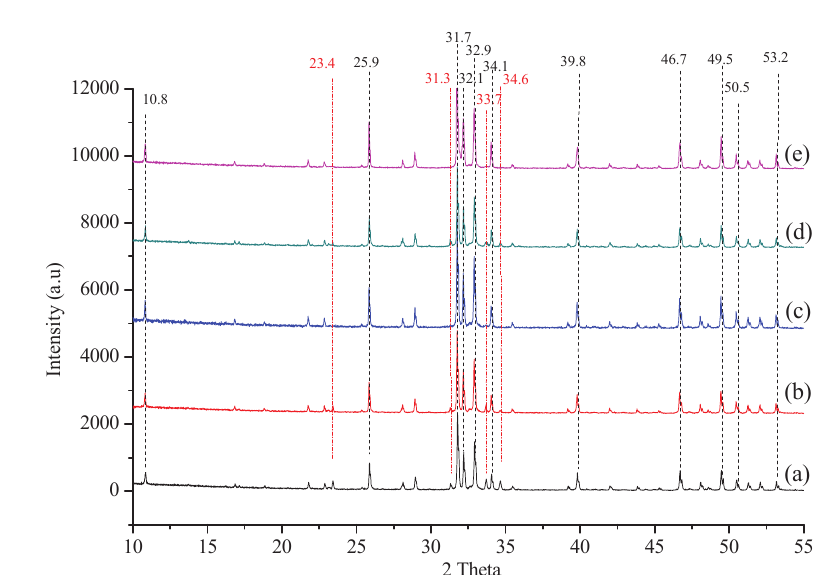
Figure 4: XRD diffraction of HA sample synthesized at: (a) pH 9 (b) pH 10, (c) pH 11, (d) pH 12 and (e) Standard HA. Fixed conditions: bovine powder/H PO = 1:10 g/mL, H PO (35 mM), reaction temperature 90°C, calcine temperature 3 4 3 4